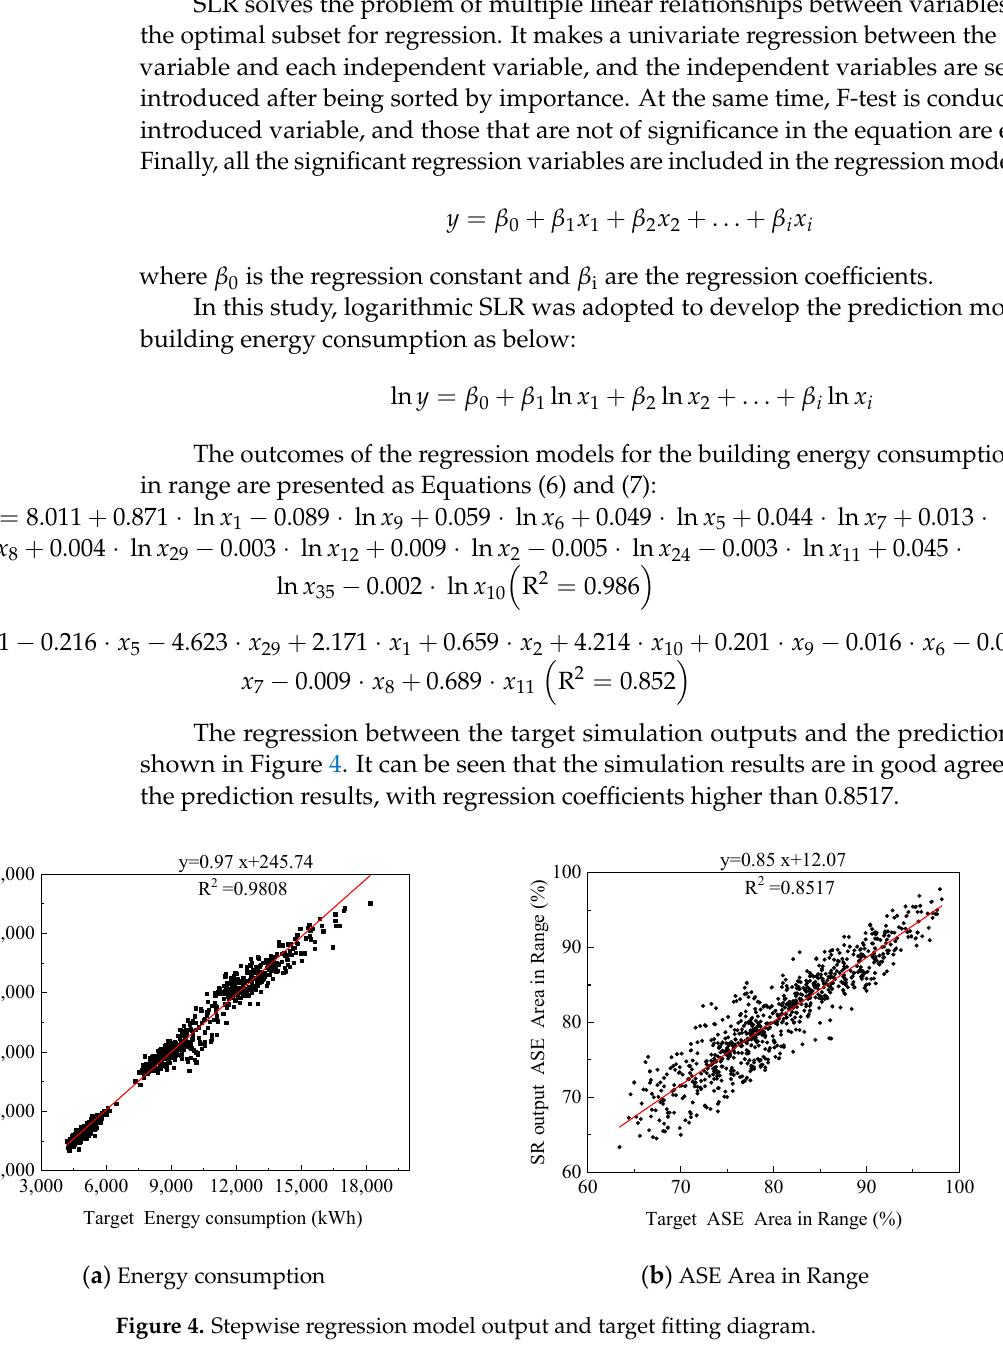
Table 5. The number of neurons in each layer. No.